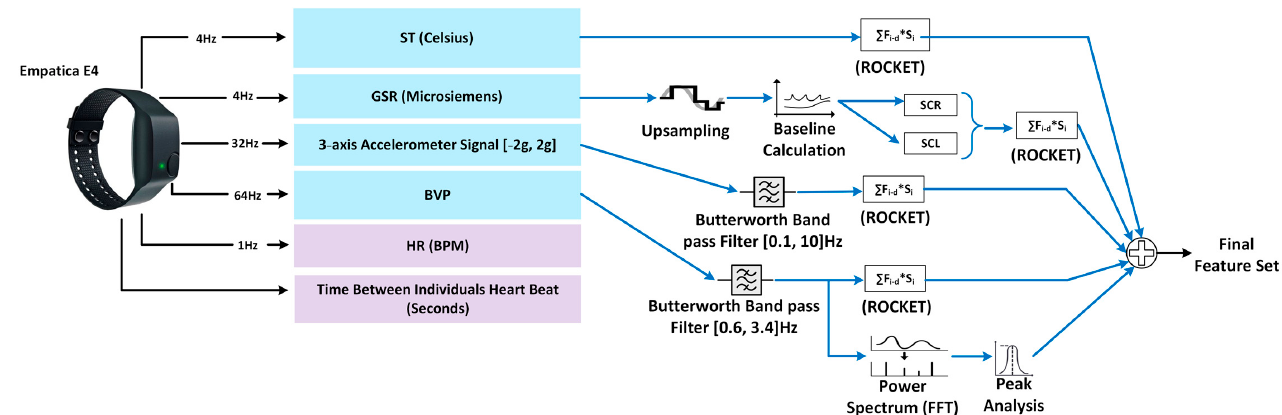
Figure 3. The pipeline of the signal processing for ROCKET feature extraction.